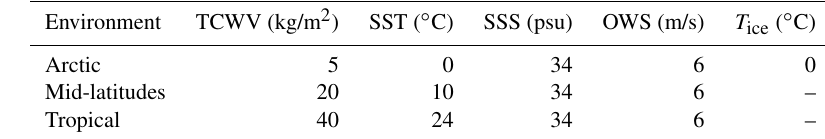
Table 2. Surface and atmospheric conditions for the three considered environments.